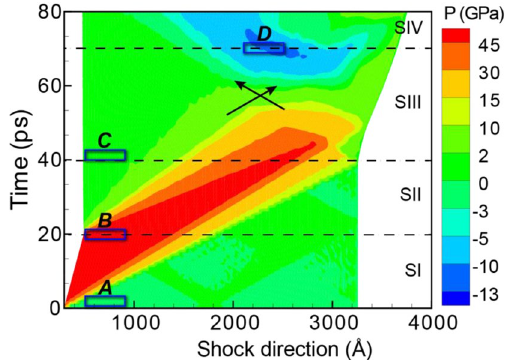
Figure 4. The temporal evolution of pressure for shocked Fe. The stages of shock are separated by dashed lines, and the region of triaxial tension is indicated by black arrows. Blue rectangles, labeled A–D, mark the regions examined in Fig. 5 and Table S2.